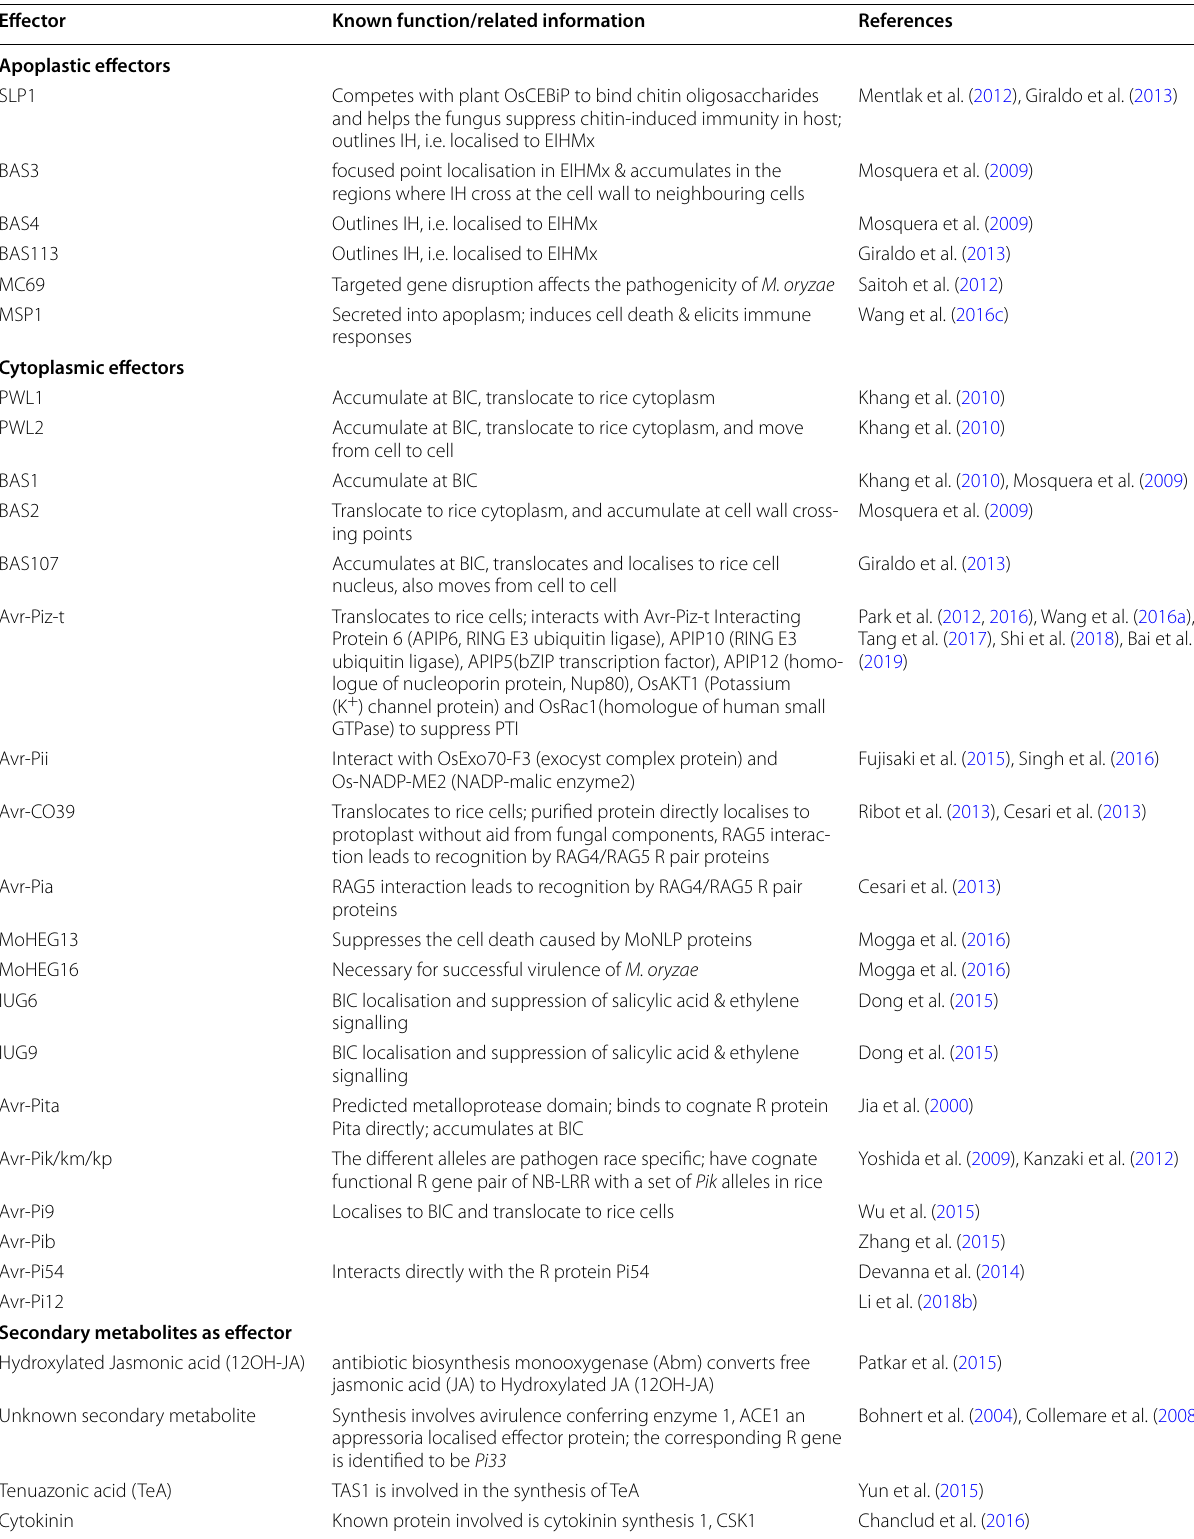
Table 3 Effectors of M.